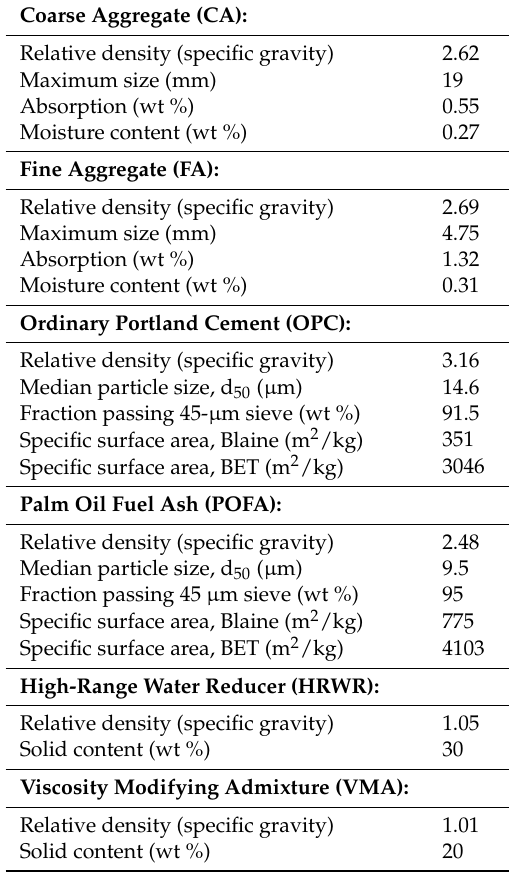
Table 1. Physical properties of concrete constituent